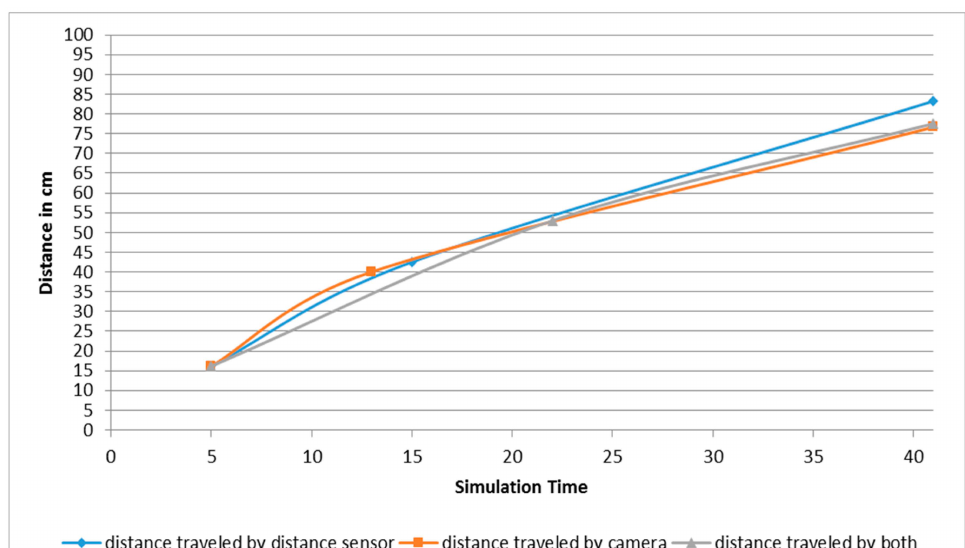
Figure 23. Distance measurements between the robot and the obstacle.